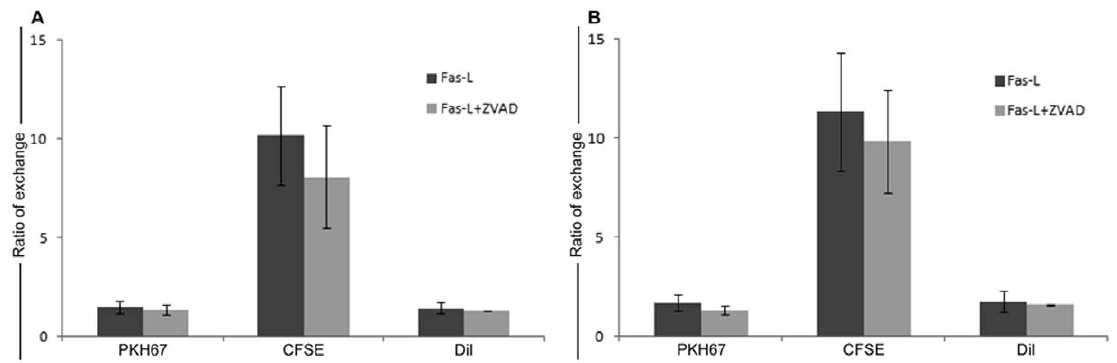
Figure 5. Effect of caspase inhibitor z-VAD on different dyes transfer. Bar diagram represent the exchange of different dyes PKH67, CFSE and DiI evaluated after FasL administration with or without z-VAD pre-treatment. The histograms highlight that z-VAD induces a weak decrease in the CFSE transfer, whereas it is negligible for the other dyes. The reduction of cytoplasmic transfer is more evident after 30 min of FasL administration (A) if compared to 1 h treatment (B). Data presented are mean 6 SD from n=3 independent